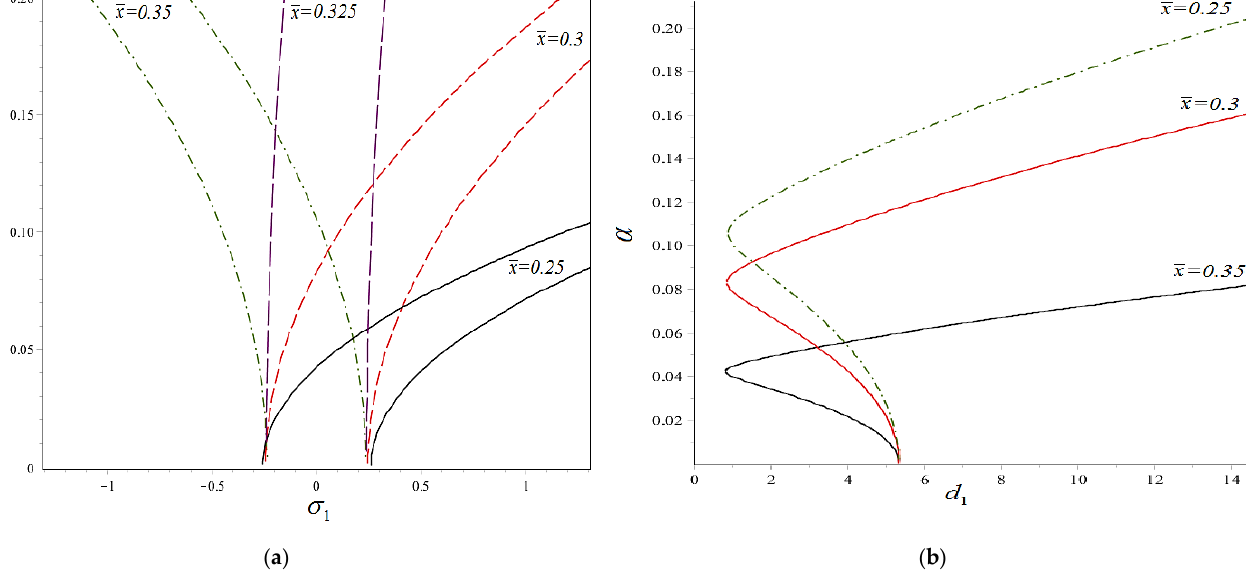
( b ) Figure 7. ( a ) Quadratic curvature waviness effect on the response of the primary resonance; ( b ) piezoelectric thickness effect on the response of the quadratic curve primary resonance. The effect of the peak point position on the frequency response of the structure with cubic curvature is investigated in Figure 8a for the primary resonance. When the position of this point is close to the structure’s end, the system’s nonlinear behavior is hard. As the position moves toward the middle, not only does softening behavior appears, but the vi- bration amplitude also decreases, which is an interesting result to be used in the predic- tion and also the design of such a curved system. In Figure 8b, the piezoelectric thickness effect is analyzed when the maximum point position is close to the end or to the middle. For both hard and soft behaviors caused by the peak point position, the thickness growth